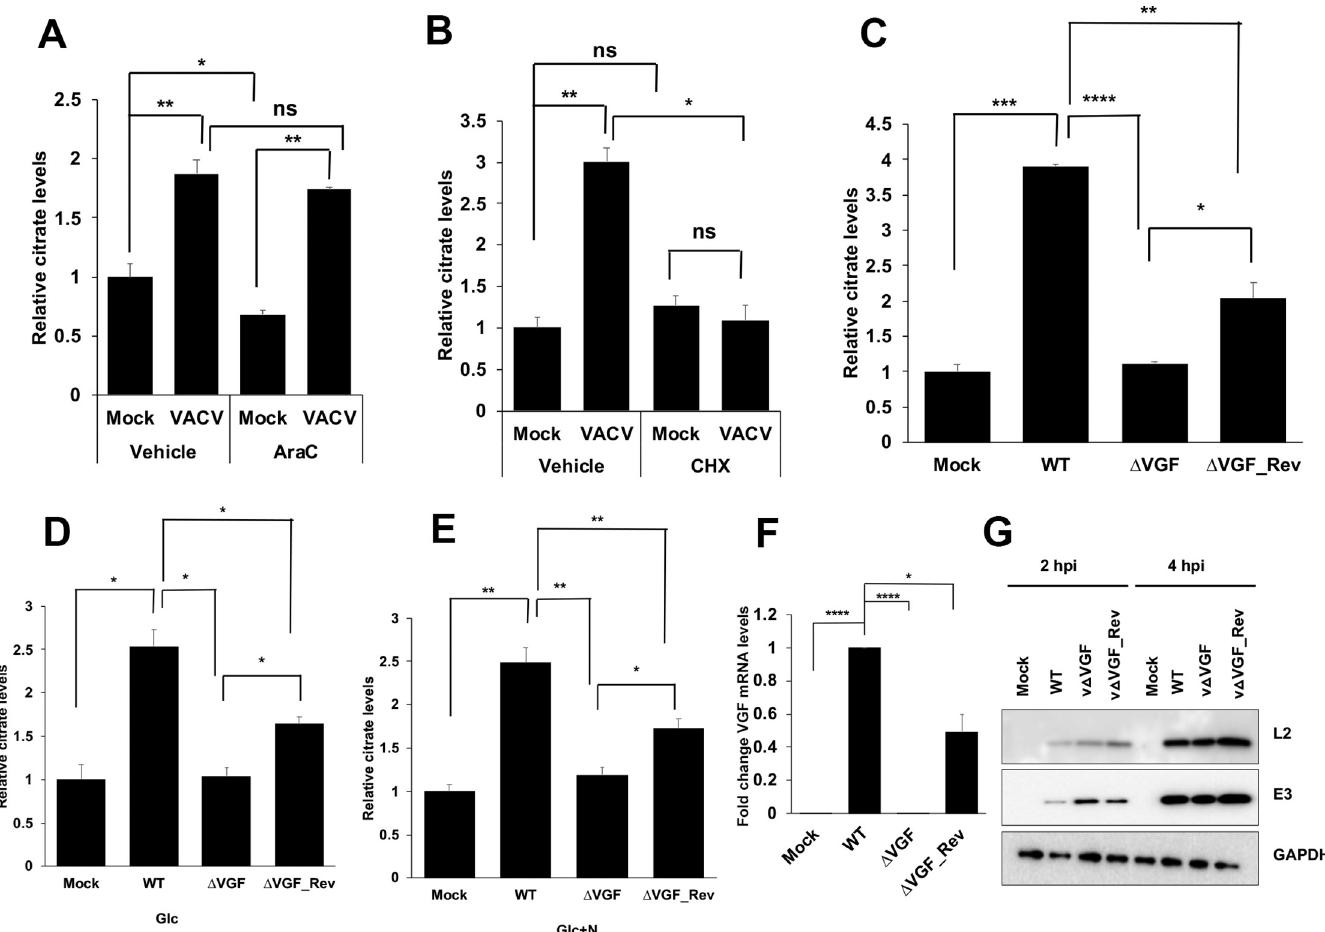
Fig 5. VACV growth factor (VGF) deletion abolishes the elevation of citrate level during viral infection. (A) Inhibition of DNA synthesis does not inhibit the increased citrate level upon VACV infection. HFFs were infected with VACV at an MOI of 5 in medium with glucose plus glutamine in the presence or absence of 40 μ g/mL AraC. Citrate level was measured at 8 hpi. (B) Inhibition of protein synthesis reduces citrate level in VACV-infected HFFs. HFFs were infected with VACV at an MOI of 5 in medium with glucose plus glutamine in the presence or absence of 100 μ g/mL Cycloheximide. Citrate level was measured at 2 hpi. (C-E) VGF is required for the elevation of citrate level during VACV infection. (C) HFFs were infected with either WT-VACV or v Δ VGF or a VGF revertant v Δ VGF_Rev at an MOI of 5 in medium with glucose plus glutamine. Citrate level was measured at 4 hpi. (D) HFFs were infected with indicated viruses at an MOI of 5 in medium with glucose only (Glc). Citrate level was measured at 4 hpi. (E) HFFs were infected with indicated viruses at an MOI of 5 in with glucose + asparagine (Glc+N), and citrate level was measured at 4 hpi. (F) VGF mRNA expression in WT-VACV, v Δ VGF, and v Δ VGF_Rev. RNA was extracted from HFFs infected with indicated viruses at an MOI of 5 for 1 h in medium with glucose plus glutamine, and reverse transcription-quantitative PCR (qRT-PCR) analysis was performed. (G) VGF deletion does not affect the levels of other VACV early proteins. HFFs infected with indicated viruses at an MOI of 5. Western blotting analysis was performed at indicated time post infection to measure the levels of VACV E3 and L2 proteins. Error bars represent the standard deviation of at least three biological replicates. ns, P > 0.05; � , P � 0.05; �� , P � 0.01; ��� , P � 0.001; ���� , P � 0.0001. affected the upregulation of citrate level in VACV-infected cells using AraC, a well-established inhibitor of DNA replication but not viral early protein synthesis [47]. AraC treatment did not inhibit the increase in citrate level upon VACV infection ( Fig 5A ), indicating an event prior to viral DNA replication could stimulate the citrate level. However, treatment with cycloheximide (CHX), a well-known inhibitor of mRNA translation [48], abolished the citrate level’s increase upon VACV infection. In contrast, cycloheximide treatment did not affect the citrate level in uninfected HFFs ( Fig 5B ). These results suggest that early VACV protein expression is required to enhance the citrate level upon VACV infection.